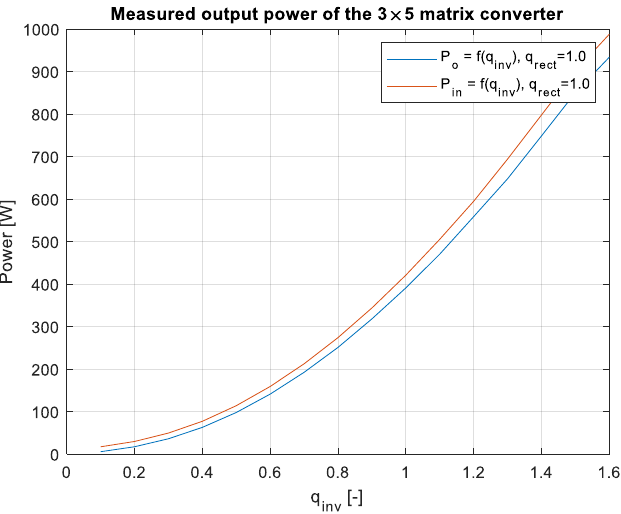
Figure 18. Input and output power as a function of inverter gain.